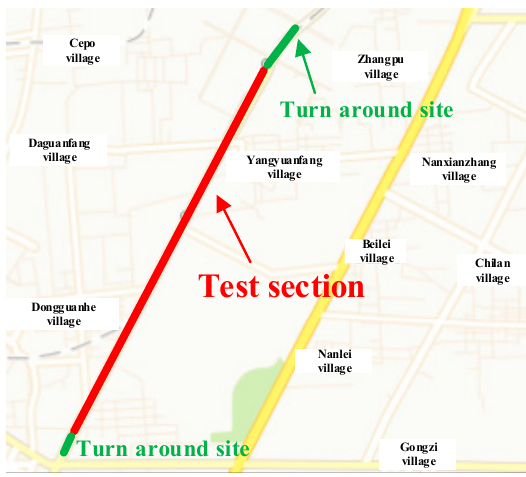
Figure 4. The map of the experimental route.